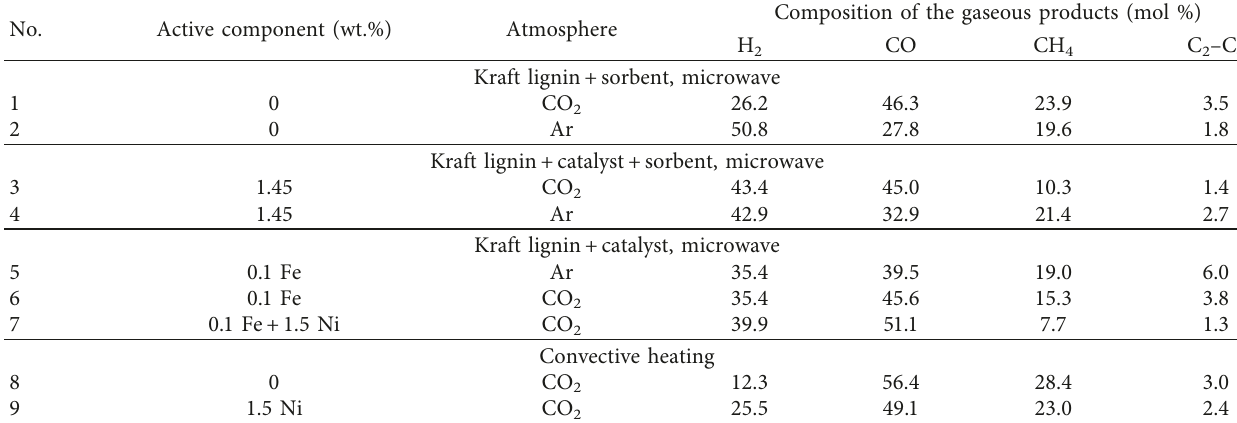
Table 2: The composition of the gaseous products of the conversion of kraft lignin. No. Active component